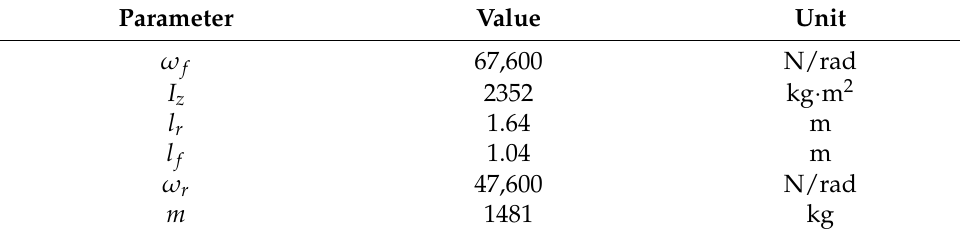
Table 1. Simulation